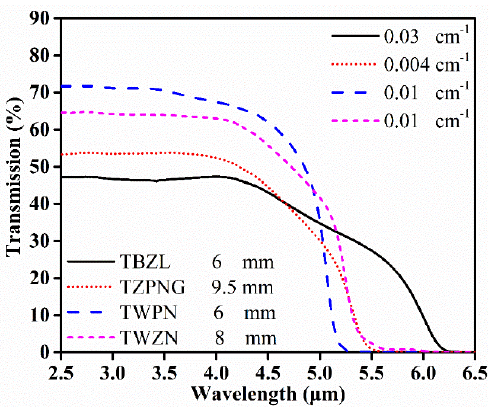
Figure 1. Transmission spectrum of the glasses used for the fabrication of step−index